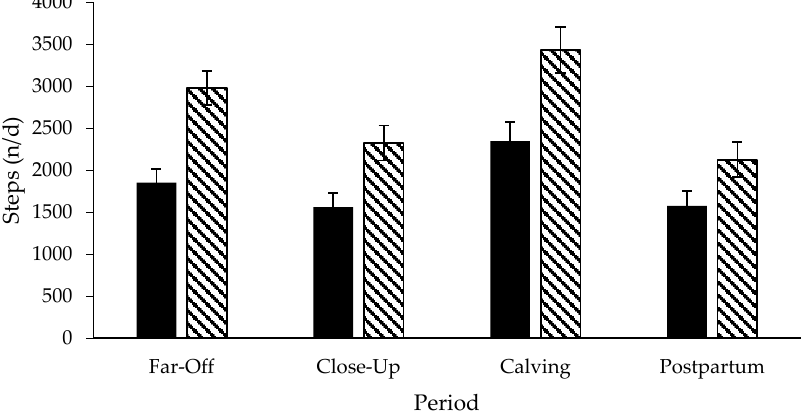
Figure 6. Daily steps of Holstein cows managed in freestalls (solid bars; n = 14) or on pasture (striped bars; n